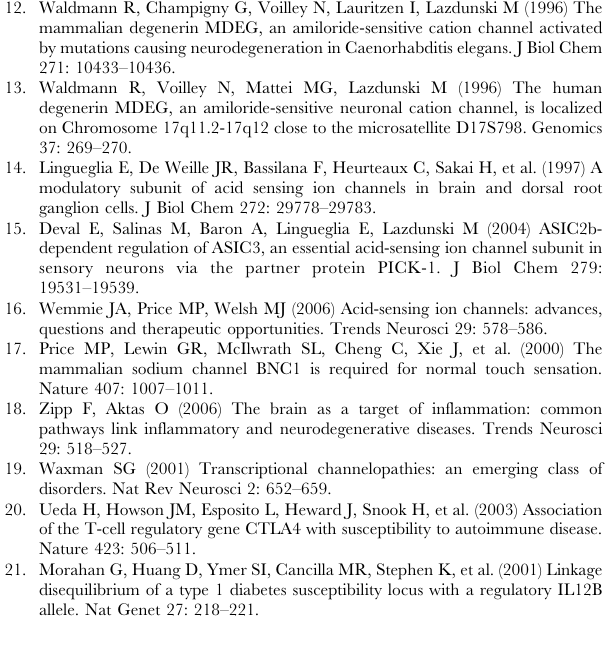
Table S3 Primer names, PCR conditions and sequence condi- tions for the exons of the ACCN1 gene.